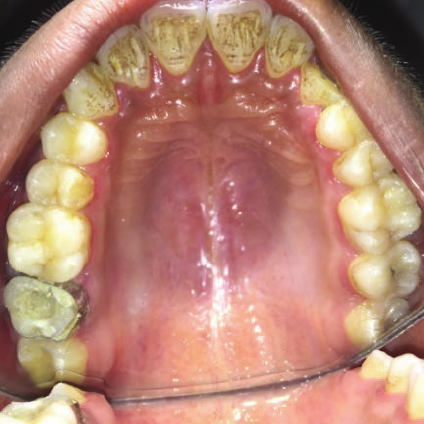
Figure 14: Photograph showing meshwork of fibre in the pulp chamber.